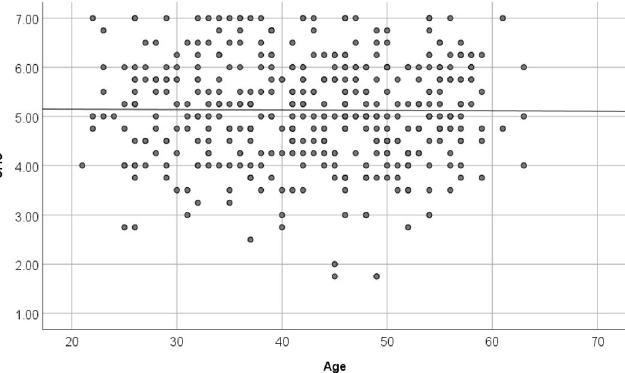
Figure 5. Scatter plot showing the relationship between age and